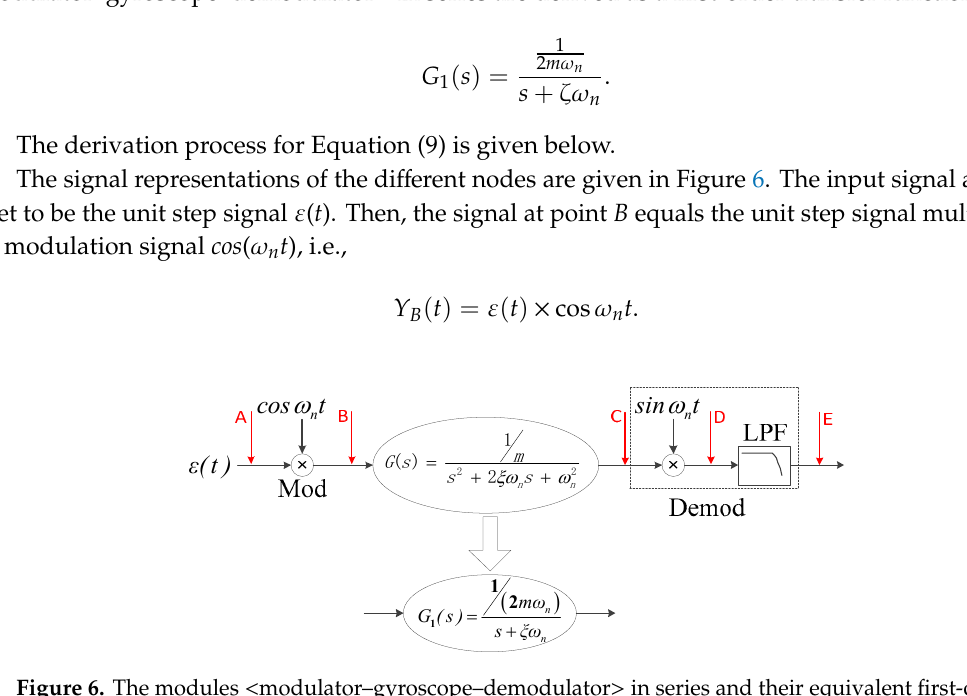
Figure 6. The modules < modulator–gyroscope–demodulator > in series and their equivalent first-order transfer function.